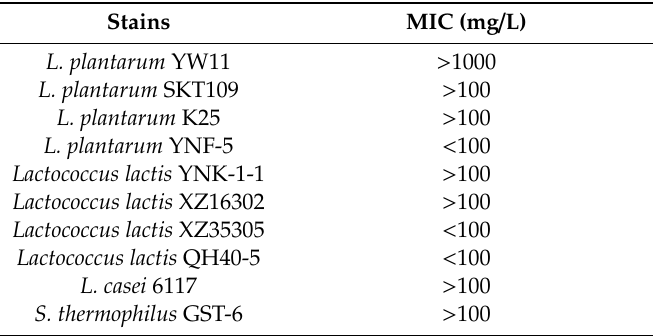
Table 1. Lead tolerance of di ff erent lactic acid bacterial strains. Stains MIC (mg /